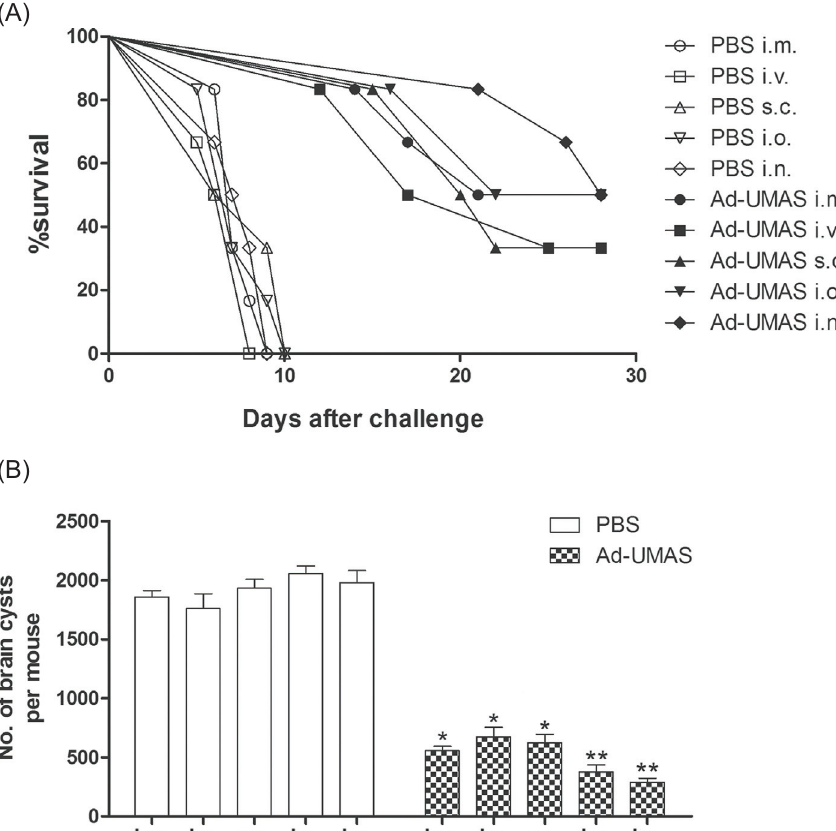
Figure 3. Evaluation of the protective ability against T. gondii infection. (A) Six immunized mice per group were infected intraperitoneally with 1 · 10 3 tachyzoites of T. gondii RH strain 4 weeks after the last immunization. Survival was monitored daily for 28 days after challenge. (B) Another six immunized mice per group were infected intragastrically with 20 cysts of T. gondii PRU strain and the cyst burden in the brain of vaccinated mice was counted 4 weeks later. The mean number of cysts in every mouse group was based on each mouse brain cyst in the group. Asterisks mark the significant difference: * p < 0.05; ** p < 0.05. Each bar represents the mean OD (± SD